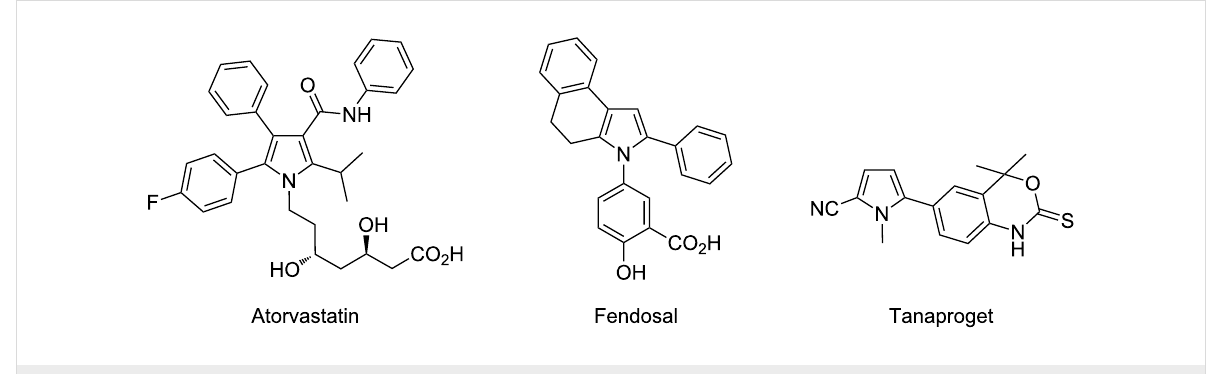
Figure 1: Examples of pyrrole-containing bioactive compounds.